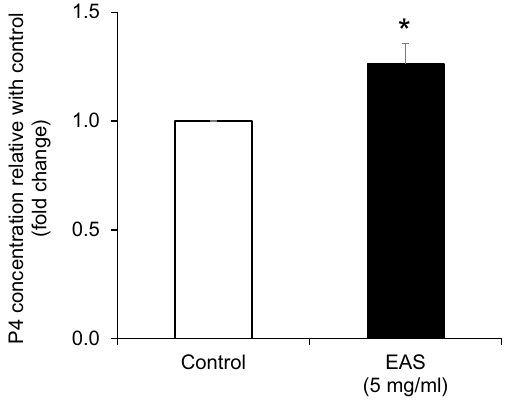
Figure 10. Effect of EAS on P4 synthesis in bovine CG cells. Cells were treated for 12 h with or without EAS (5 mg/ml) under normal conditions at 38.5 °C (control, EAS group). Data are shown as the mean ± SEM, n = 8, * P < 0.05, vs.